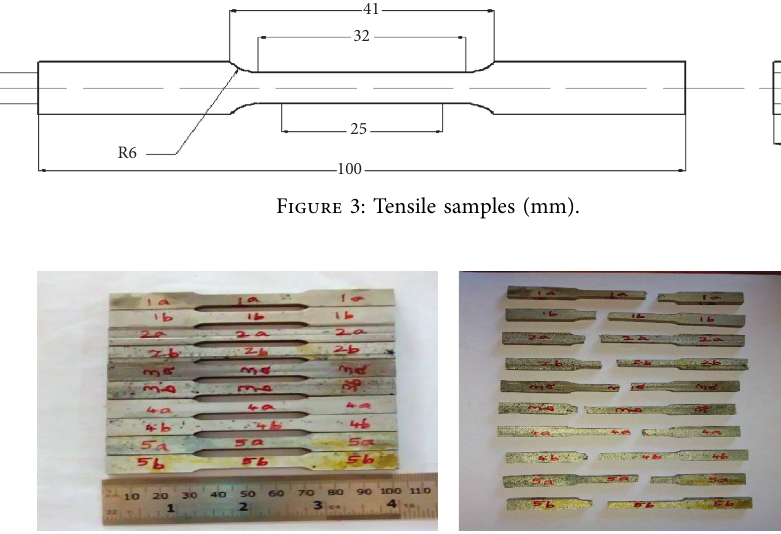
Figure 4: Tensile samples before and after tensile test of LM6 Al alloy hybrid